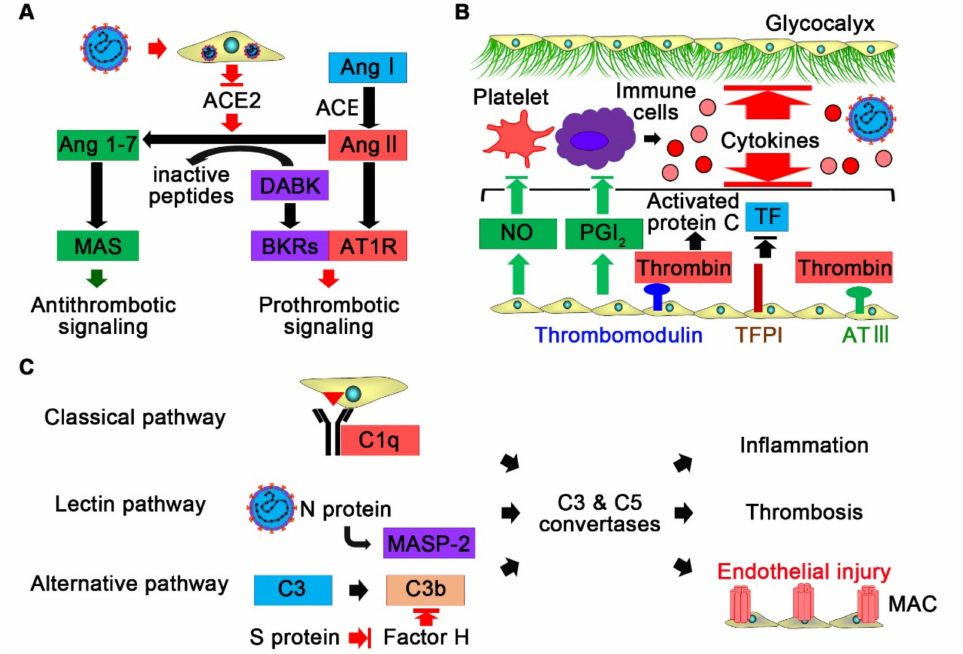
Figure 4. Endothelial dysfunction in COVID-19. ( A ) SARS-CoV-2 infection reduces ACE2 expression on endothelial cells, which leads to activation of the kallikrein–kinin system and the renin–angiotensin system. Increased des-Arg(9)-bradykinin (DABK) and angiotensin II (Ang II) activate bradykinin receptors (BKRs) and type 1 angiotensin receptors (AT1R) for prothrombotic signaling and endothe- lial dysfunction, whereas antithrombotic signaling via MAS receptors stimulated by Ang 1–7 is reduced. ( B ) Sustained immune responses in COVID-19 cause endothelial dysfunction through suppressing expression of anti-inflammatory and antithrombotic factors, such as nitric oxide (NO), prostacyclin (PGI2), thrombomodulin, activated protein C, tissue factor pathway inhibitor (TFPI), and antithrombin III (AT III), and degradation of glycocalyx. ( C ) SARS-CoV-2 infection activates the complement system via the classical, lectin, and alternative pathways. Activation of C3 and C5 convertases leads to inflammation, thrombosis, and endothelial injury. MAC, membrane attack complex; MASP-2, mannose-binding lectin-associated serine protease